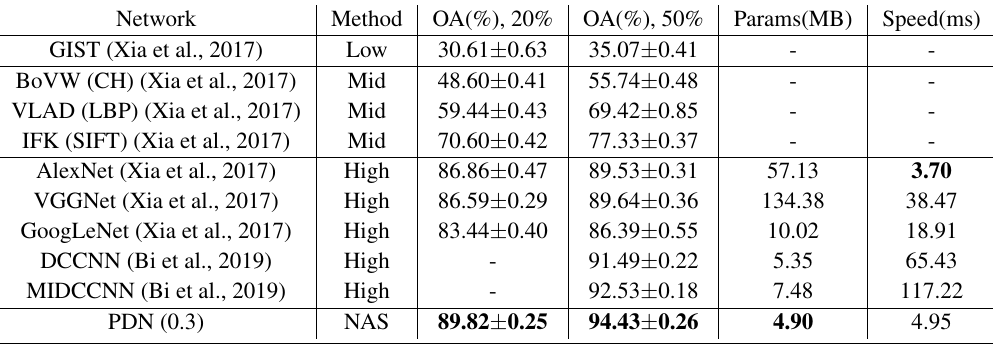
Table 1. Comparison results of the proposed ProbDenseNet (0.3) on 20% and 50% AID respectively.